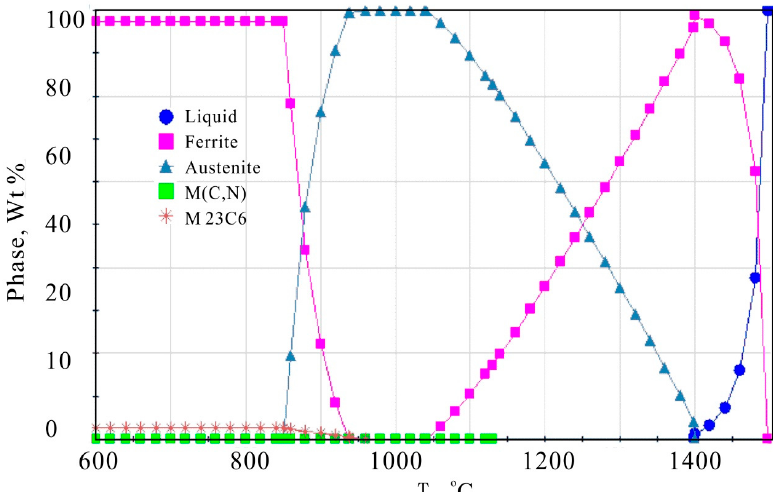
Figure 2. Phase diagram of 1Cr13MoS (the chemical composition is the measured value as shown in Table